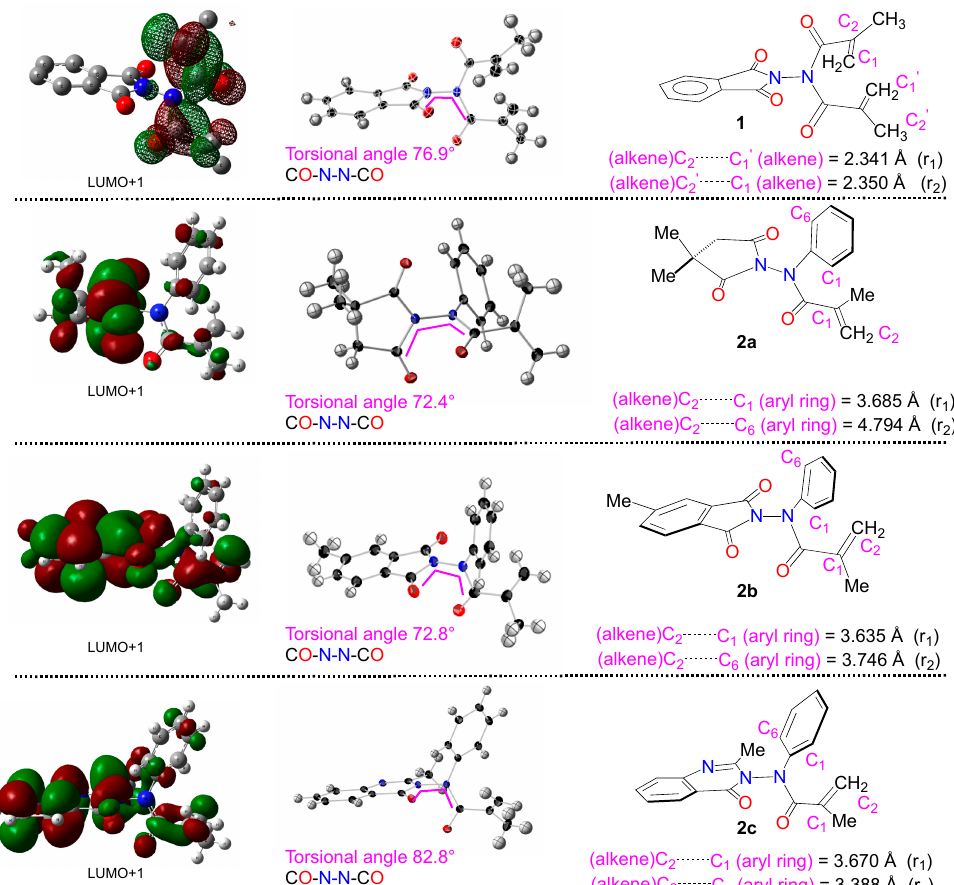
Figure 1. Understanding the solid state photochemical reactivity based on orbital density computed with Gaussian 09 at B3LYP/6-31G* and single crystal XRD analysis of hydrazides 1 , 2a , 2b , and 2c . Based on chiral stationary phase based HPLC analysis, the quinazolinone derived hydrazide 2c